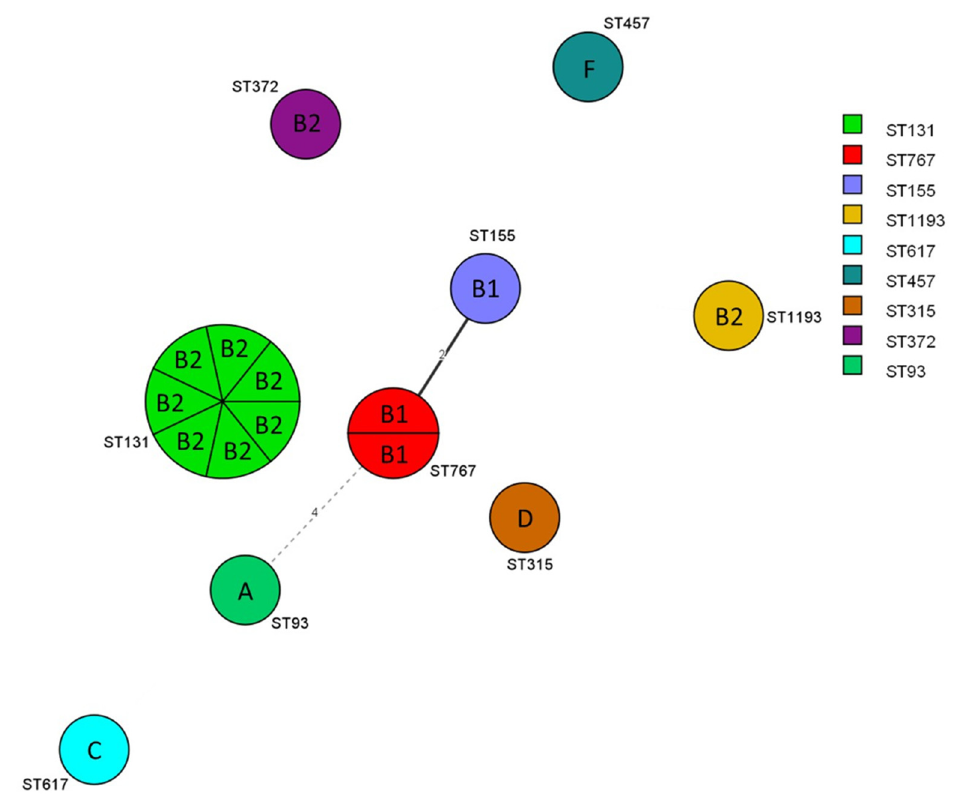
Figure 1. Minimal spanning tree of ESBL- and/or pAmpC-producing E. coli . Each circle indicates one sequence type (ST), divided into one sector for each isolate. The phylogenetic group is displayed within the sector, and each circle is bordered by the ST number. The numbers on the connecting line between STs within the MSTree indicate the number of different alleles. Solid and dotted lines represent allele differences of ≤ 3 and 4, respectively; allele differences >4 are not displayed.